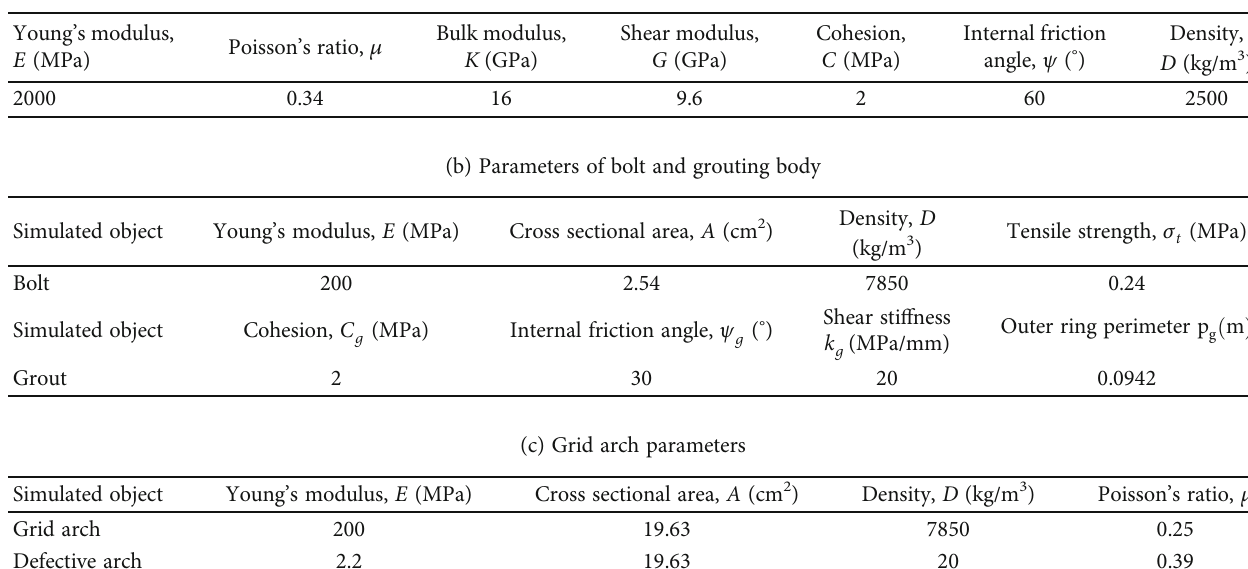
Table 3: Primary support parameters of tunnel surrounding